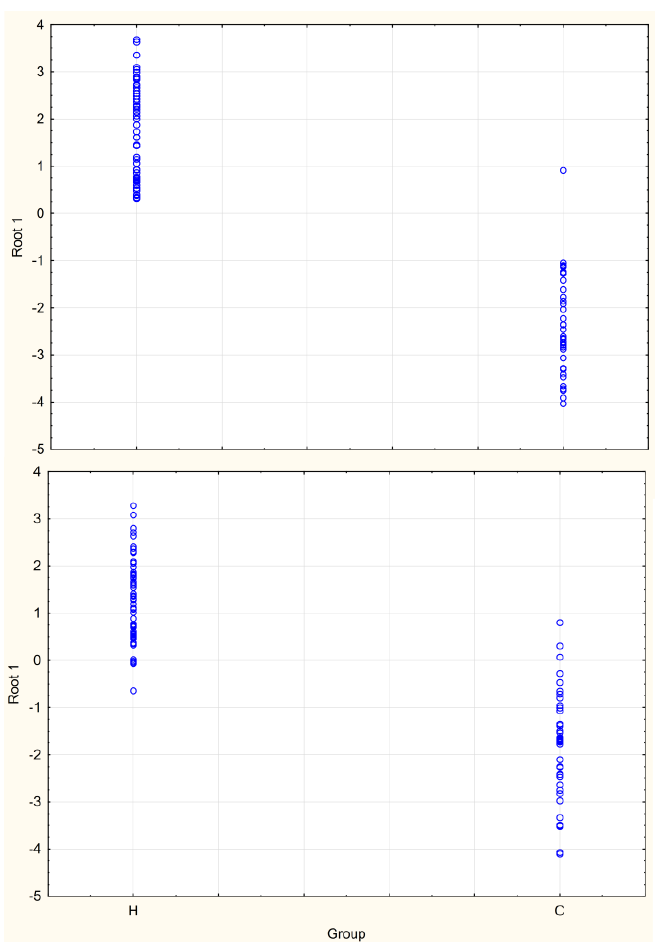
Figure 3. Canonical root scores in both groups, where the upper graph consists of “negative markers” and the lower consists of only positive markers. H — healthy persons and BC — cancer patients. Artificial neural networks (ANN) turned out to be the best method of classification.